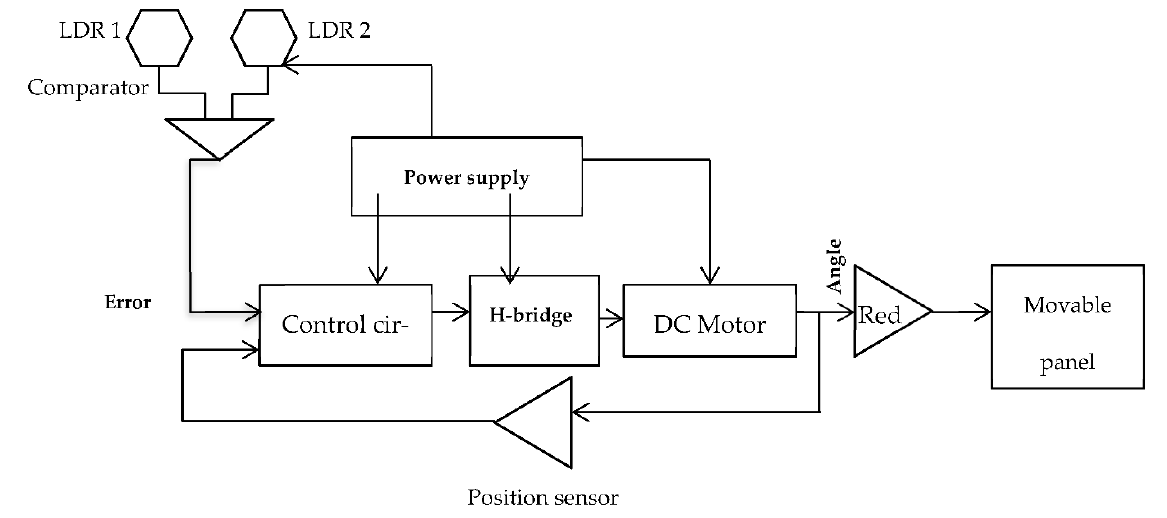
Figure 1. Block diagram of a single ‐ axis tracker.